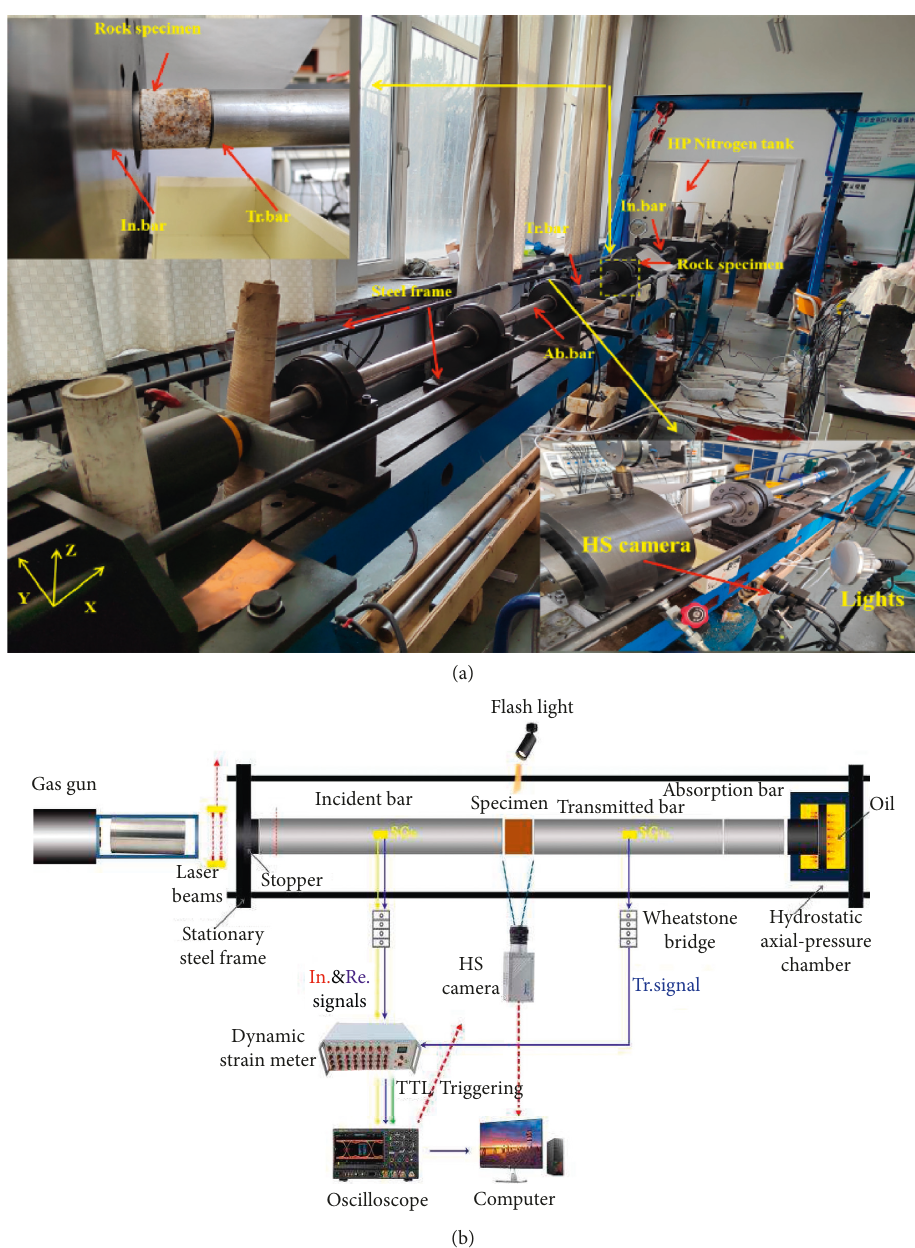
Figure 2: The SHPB test system: (a) a photograph of the SHPB device and (b) a schematic diagram of the SHPB